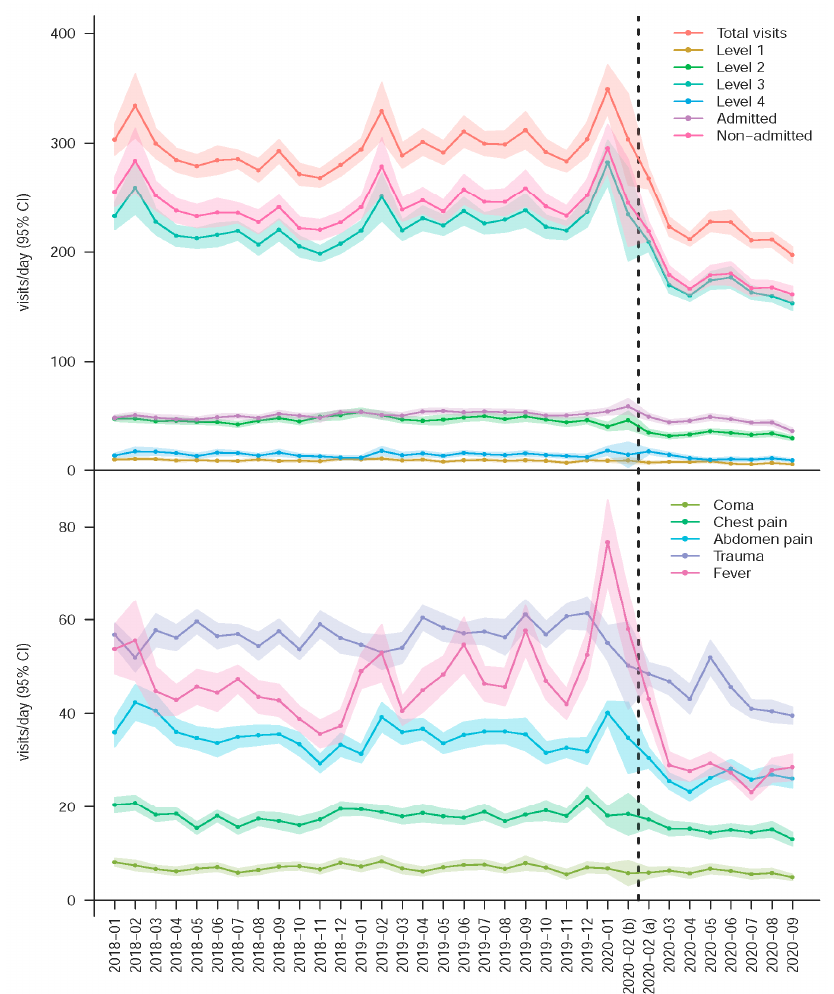
Figure 1. Daily visits to the emergency department (ED) by acuity and disease characteristics. The solid lines are the means and the areas are the 95% conference intervals. The dotted line is the divide between before and after the start of the COVID-19 pandemic.